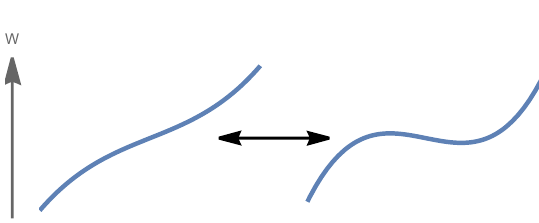
Figure 6. Change in the form of the superpotential as one crosses an orange or green line in figure 5. A pair of vacua of opposite statistics (singlet mass) (dis-)appear at a finite point in